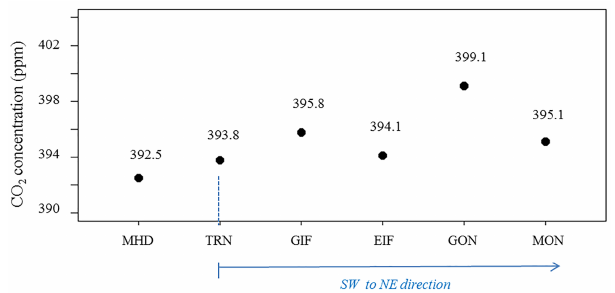
Figure 10. Mean CO 2 concentration (in ppm) observed at the differ- ent stations of the Paris regional network (TRN represents the mea- surements at 50ma.g.l.) and at MHD for wind speed higher than 9ms − 1 over the period of study (8 August 2010–13 July 2011). During such events, the synoptic conditions were mostly oceanic (wind blowing from the SW sector). Note (in ma.g.l.): MON is at 9m (NE rural site), GON is at 4m (NE peri-urban site), EIF is at 317m (urban site), GIF is at 7m (SW peri-urban site), TRN50 is at 50m (SW rural site), TRN180 is at 180m (SW rural site) and MHD is at 15m (remote site).